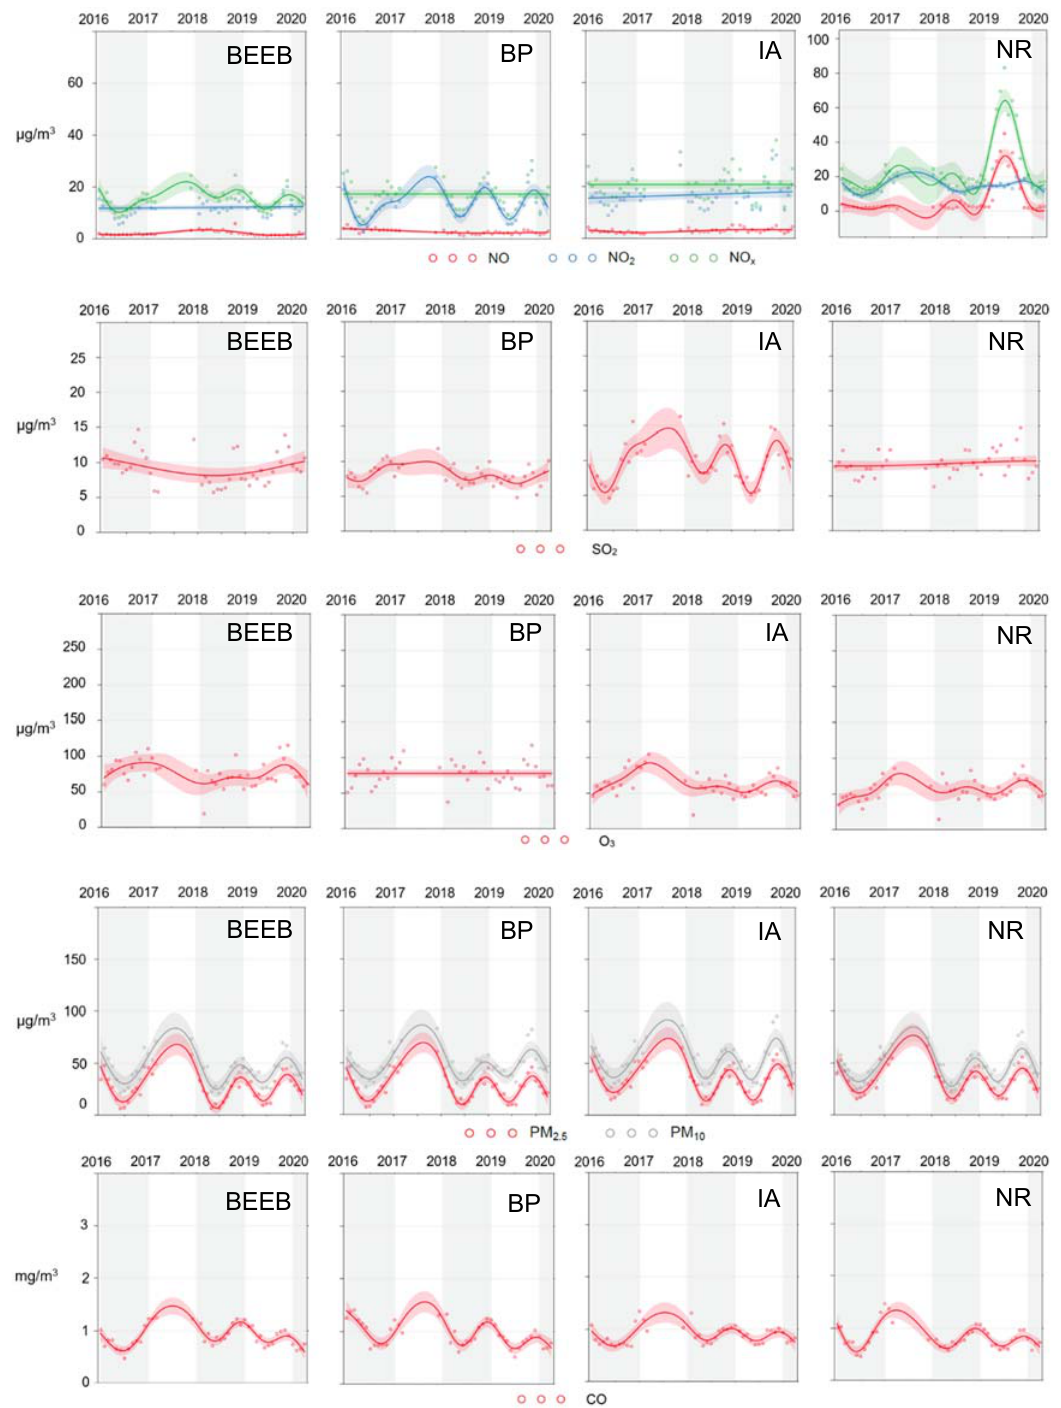
Figure 4. Long-term trends of analyzed pollutants based on national-station ground measurements. BEEB, BP, IA and NR are abbreviations of the names for four national monitoring stations (see Table 1).